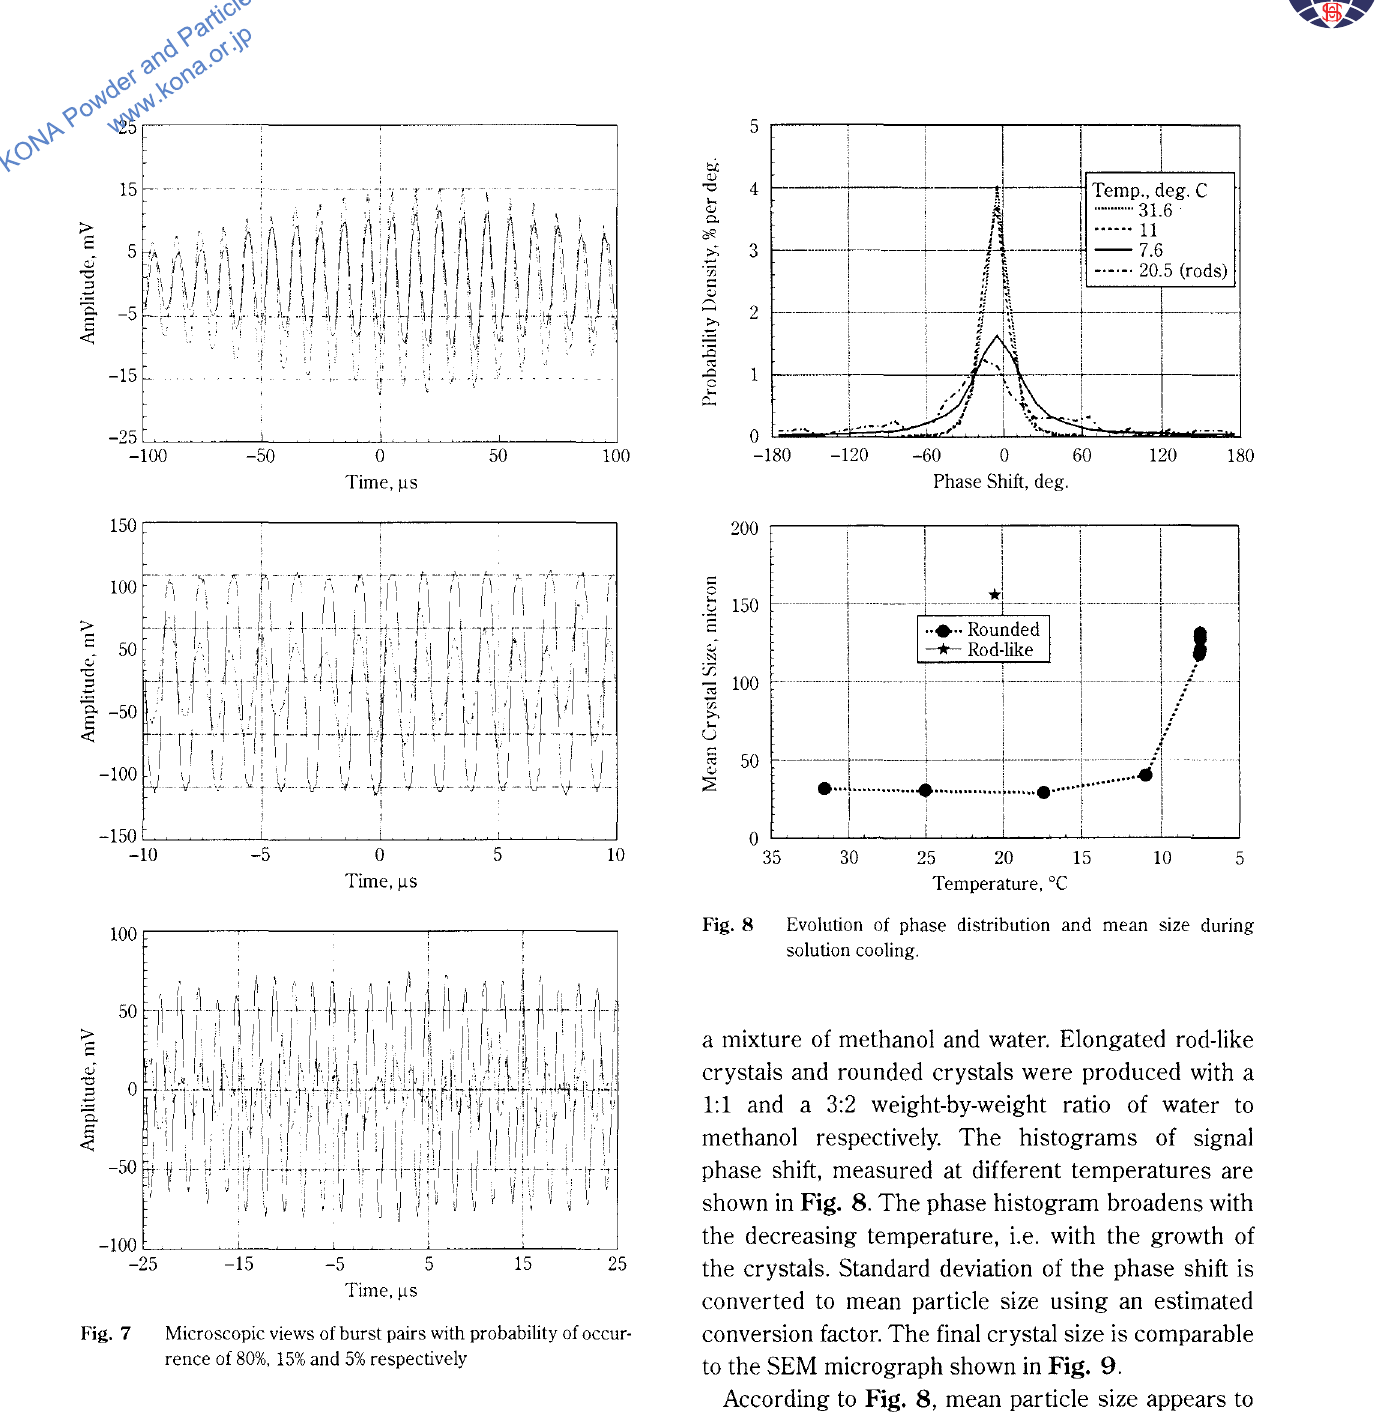
a mixture of methanol and water. Elongated rod-like crystals and rounded crystals were produced with a 1:1 and a 3:2 weight-by-weight ratio of water to methanol respectively. The histograms of signal phase shift, measured at different temperatures are shown in Fig. 8. The phase histogram broadens with the decreasing temperature, i.e. with the growth of the crystals. Standard deviation of the phase shift is converted to mean particle size using an estimated conversion factor. The final crystal size is comparable to the SEM micrograph shown in Fig. 9. According to Fig. 8, mean particle size appears to be invariant over a wide range of initial temperatures (from 35oC to 15°C). The measured standard devia tion over this range was about 10°. The actual stan dard deviation may have increased from a very small value to about 10°, i.e. the measurement resolution appears to be limited to 10°. Figure 10 shows the correlation between the velocity and the standard deviation of phase shift for rounded particles. These curves represent size-veloc ity correlations and indicate that the fastest upward motion (>0.6 m/ s) is clearly exhibited by smaller